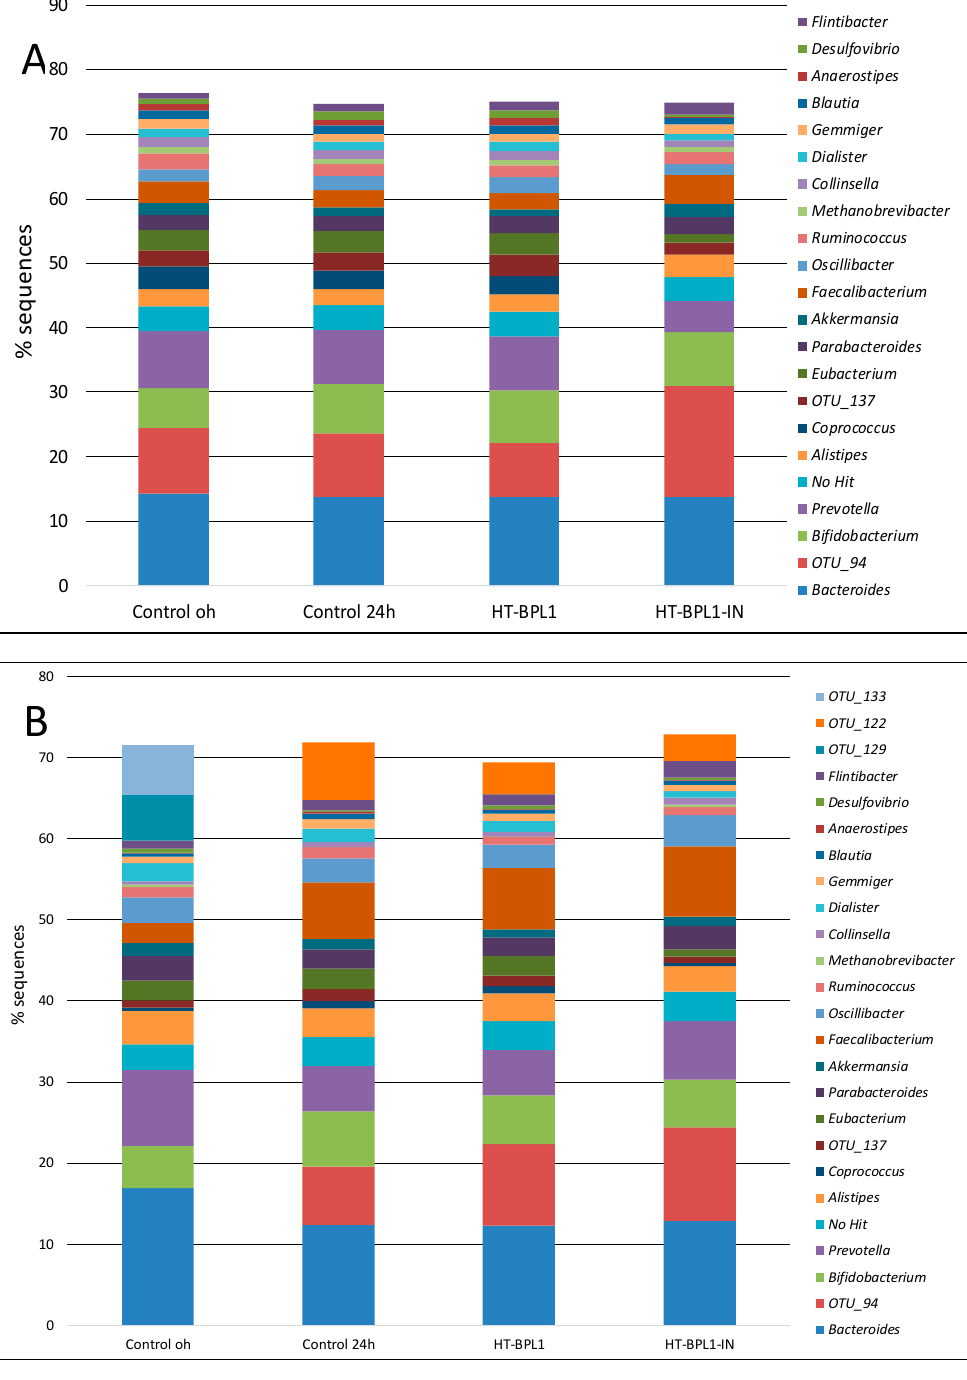
Figure 4. Percentage of identified microorganisms by 16s rRNA by Illumina V3-V4 sequencing. ( A ) experiments run with two different baby slurries in the presence of 10 8 HT-BPL1 cells; ( B ) experiments run with two different baby slurries in the presence of 10 9 HT-BPL1 cells.